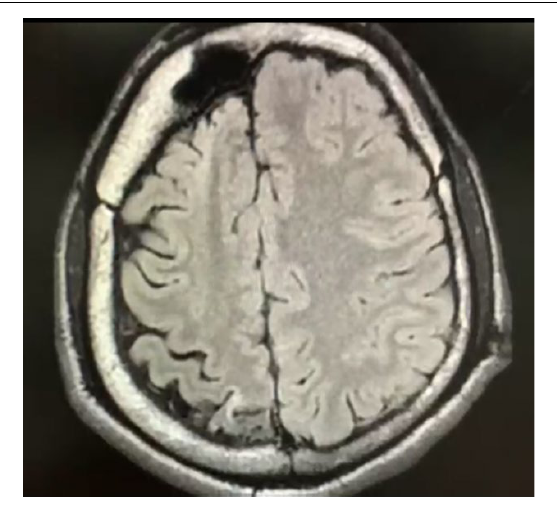
Figure 1 . MRI Showing Right Cerebral Atrophy with Gliotic and Encephalomalacic Changes Along with Compensatory Thickening of Cranial Vault.